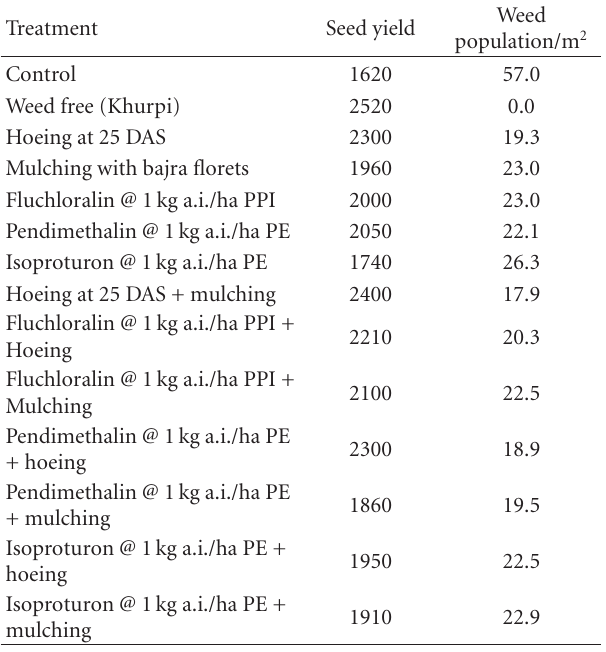
Table 11: Seed yield (kg/ha) and weed population/m 2 as influenced by di ff erent weed control